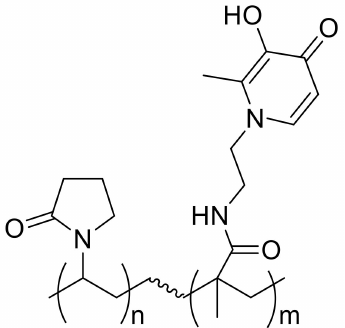
Figure 2. Chemical structure of the 3-hydroxypyridin-4-one of